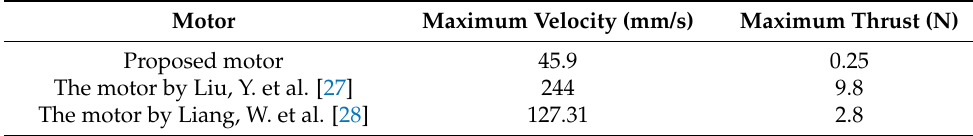
Table 3. Comparison of the output performances of the three motors.